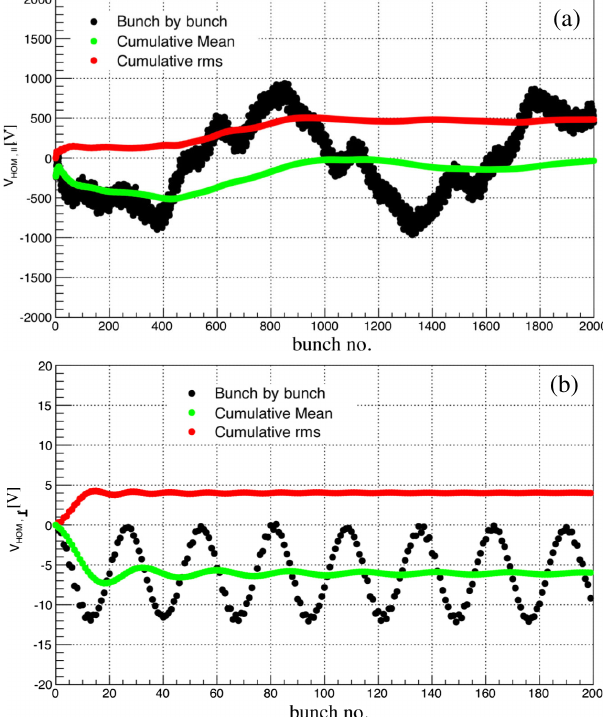
FIG. 14. (a) Monopole HOM voltage and (b) dipole HOM voltage for the five-cell 650 MHz